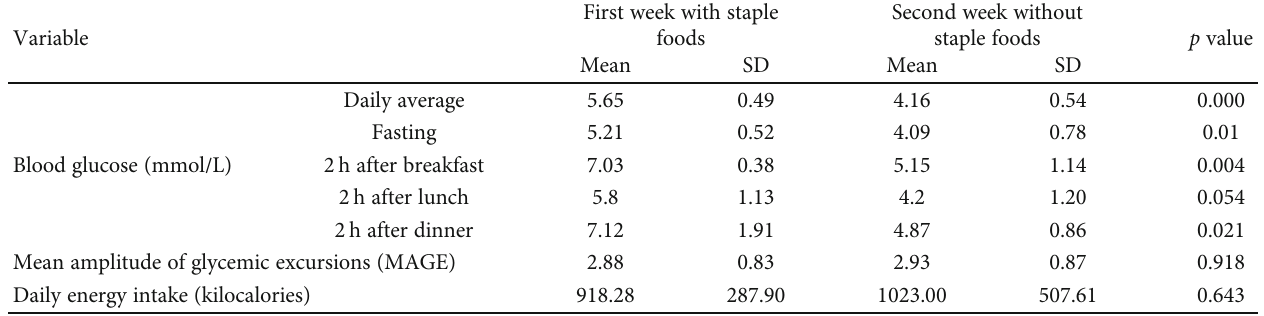
Mean amplitude of glycemic excursions (MAGE)